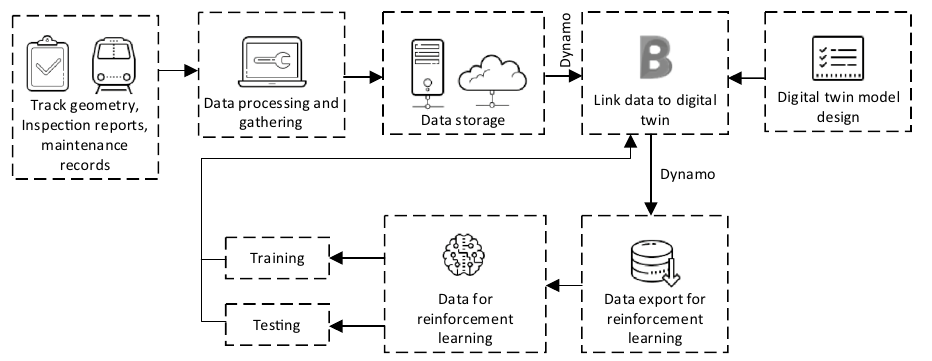
Figure 8. Digital twin and reinforcement learning model integration.